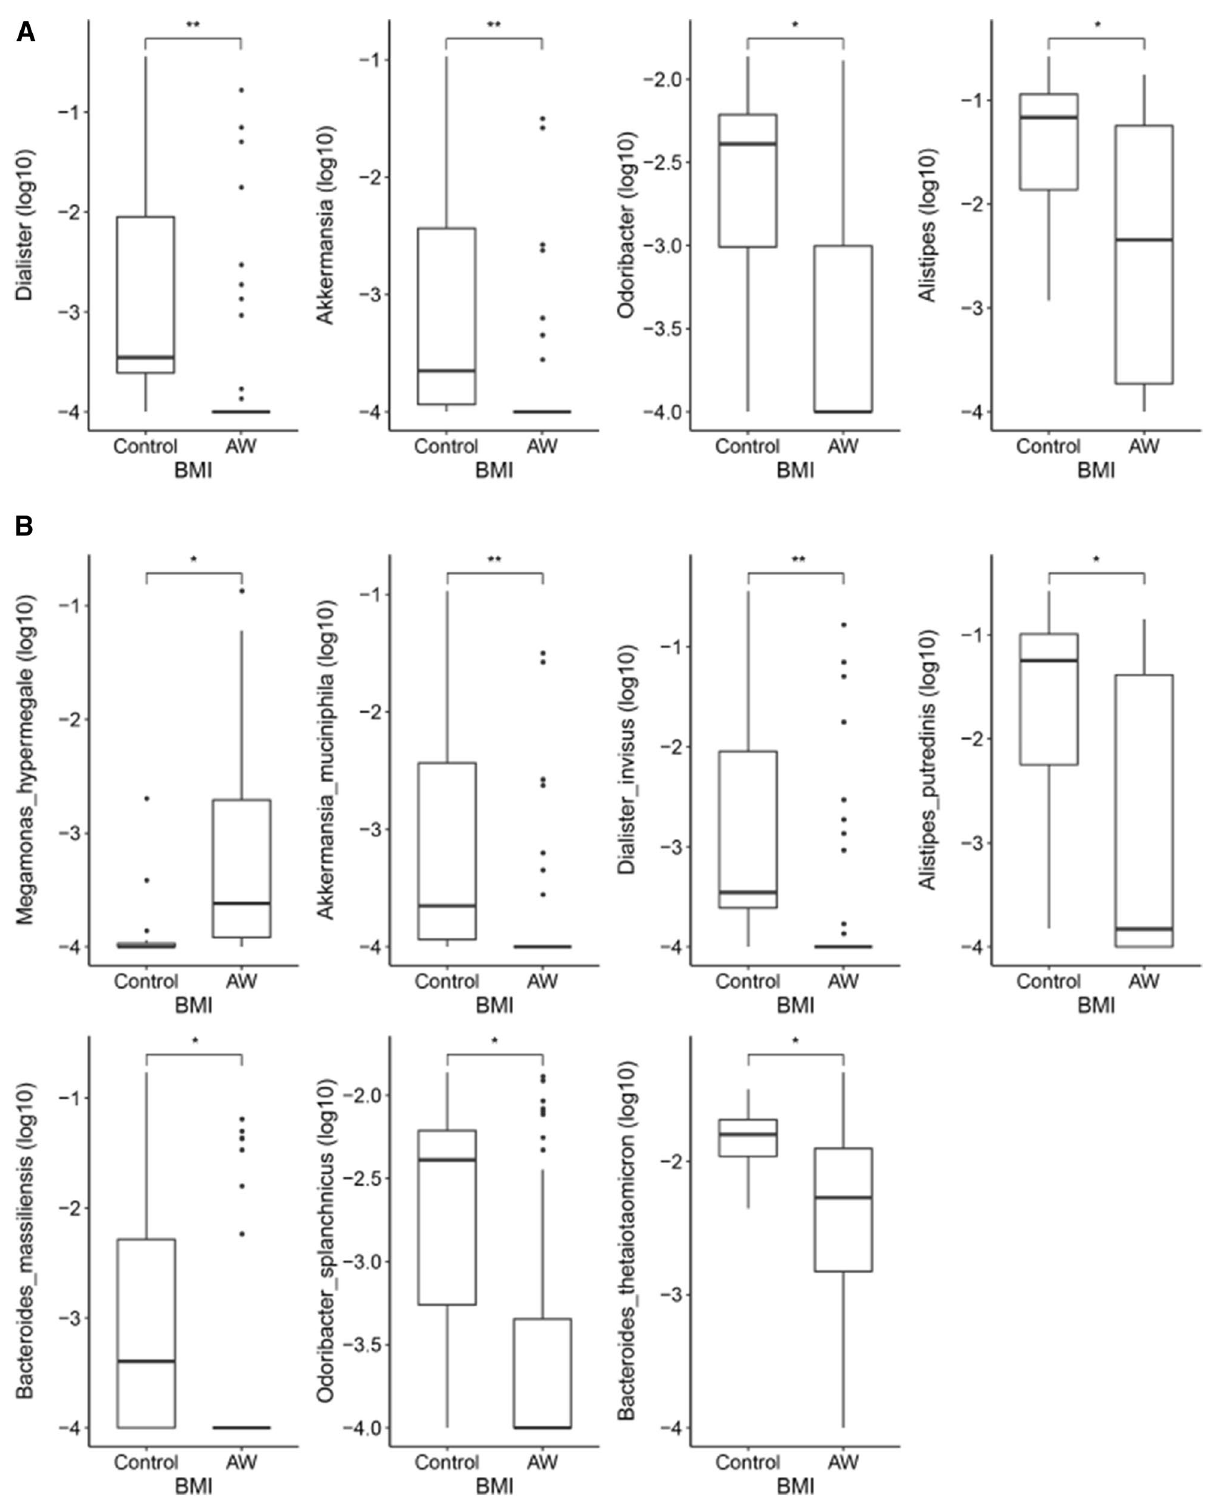
Figure 3. Comparison of gut microbial compositional features at the genus and species levels between the BMI groups using the Wilcoxon rank-sum test. ( A ) At the genus level, Dialister , Akkermansia , Odoribacter , and Alistipes exhibit a significant decrease in AW children compared with the Lean children. ( B ) At the species level, Megamonas hypermegale is increased in the AW group, while Akkermansia muciniphila , Dialister invisus , Alistipes putredinis , Bacteroides massiliensis , Odoribacter splanchnicus , and Bacteroides thetaiotaomicron are decreased in AW children compared to the Lean group. Note: *, BH-adjusted P < 0.05; **, BH-adjusted P < 0.01; ***, BH-adjusted P <